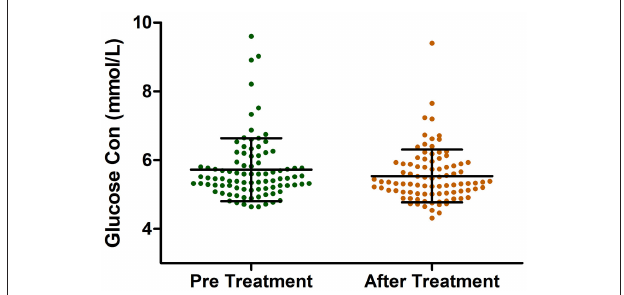
FIGURE 1 | The Glucose Levels in patients with psoriasis pre and after acitretin treatment for 8